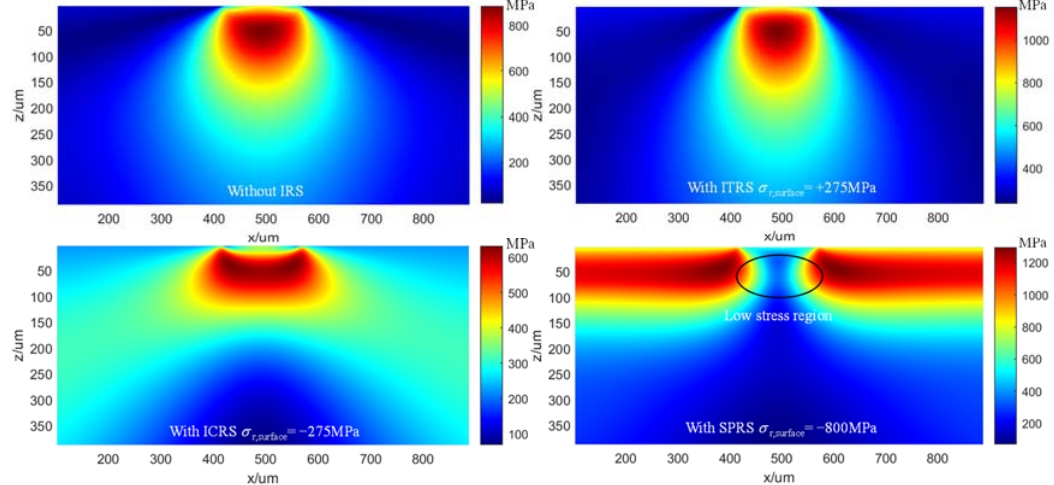
Figure 23. The effect of initial residual stress on the von Mises stress field ( P h = 1.56 GPa).